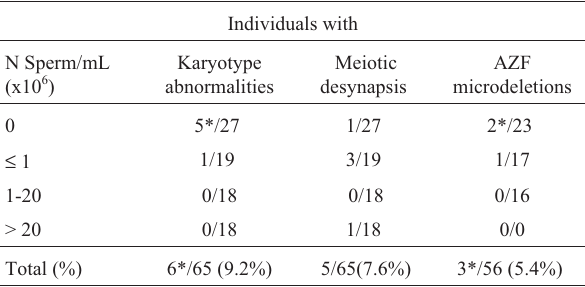
Table 4 - Distribution of AZF microdeletions, and karyotype and meiotic abnormalities according to sperm counts in infertile